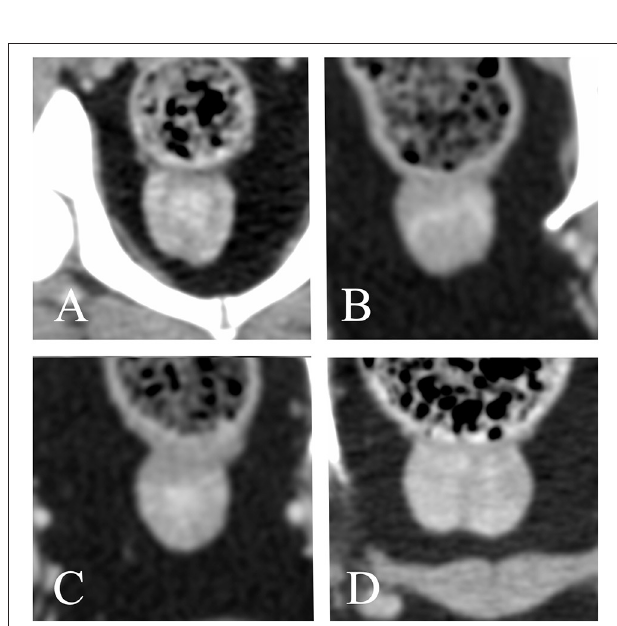
FIGURE 5 | Transverse reconstructions of the prostate showing different pattern of contrast enhancement. (A) Peripheral enhancement. (B–D) Heterogeneous, randomly distributed contrast enhancement. (A,C) urethral enhancement. (A,B,D) A shallow notch in the ventral surface of the prostate marks the boundary between right and left lobe. (B) Slightly asymmetrical prostate. (C) No ventral notch allowing a clear distinction between right and left lobe is noted. (D) A prominent median septum is